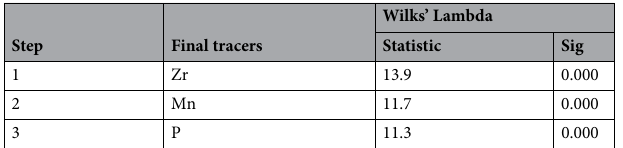
Table 1. The final composite signature selected by both TRT + KW + DFA and TRM + KW + DFA for discriminating the three sub-basin spatial sources of the six target sediment samples collected at the outlet of the study